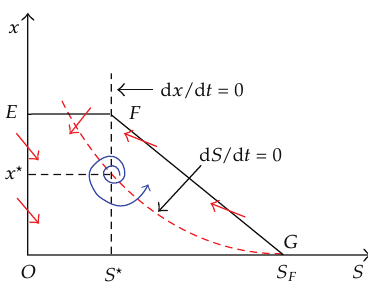
Figure 2: The case for (cid:5) S (cid:2) ,x (cid:2) (cid:6) is unstable and system (cid:5) 2.5 (cid:6) has a limit